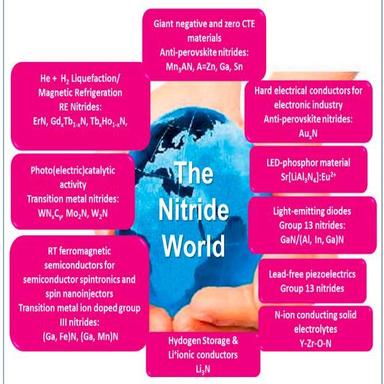
The Nitride World: Overview of a selection of emerging functionalities of various inorganic nitrides (for details see references).